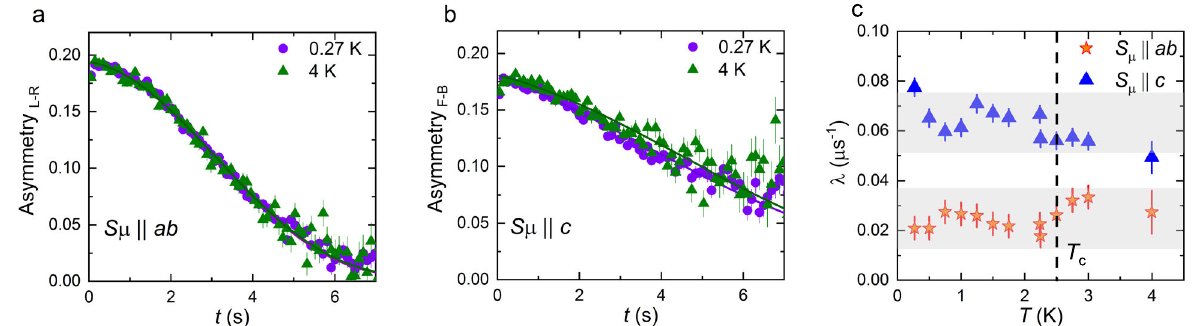
Fig. 4 Results of ZF- μ SR experiments. a and b ZF- μ SR spectra above and below T c collected in zero fi eld with the initial muon spin polarization being S μ (0) ∣∣ ab and S μ (0) ∣∣ c , respectively. The solid lines through the spectra are fi ts as described in the text. c The resulting ZF exponential relaxation rates Λ ( T ) are almost independent of temperature, thus indicating a preserved TRS. The error bars represent the SD of the fi t